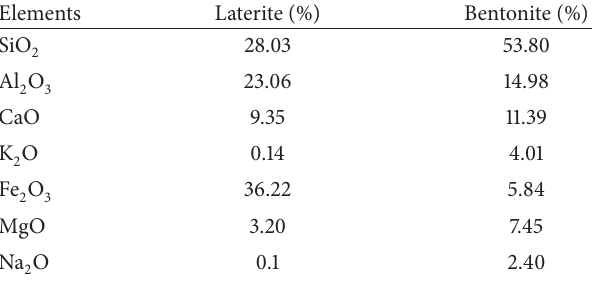
Table 1: X-ray fluorescence results of clay mineral. Elements